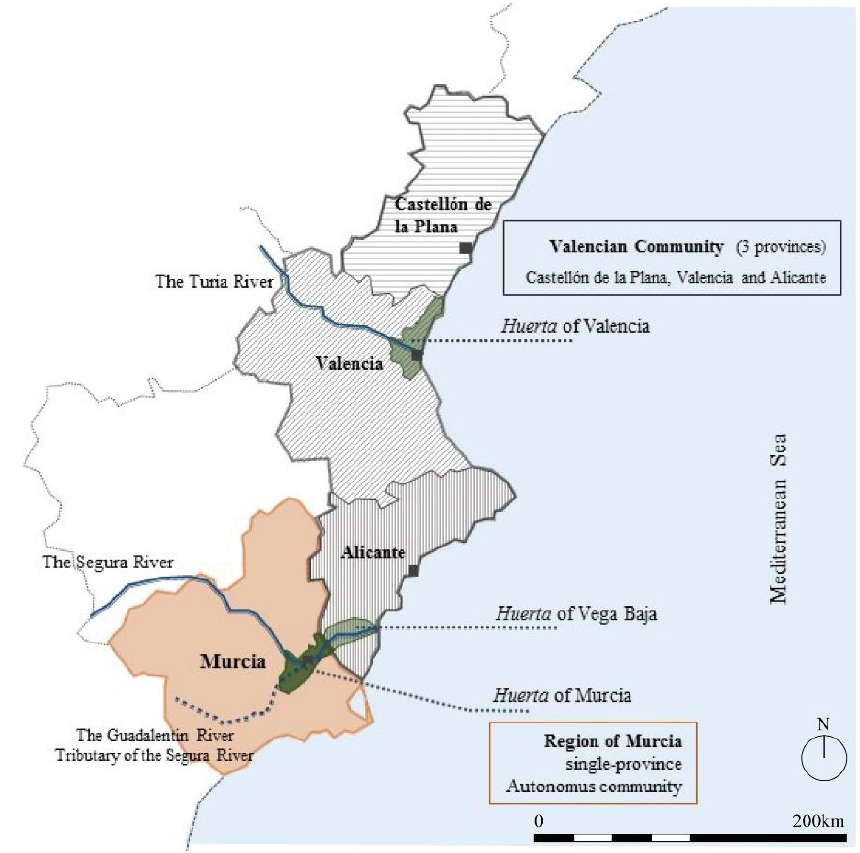
Figure 2. Location map. Regional context and main river courses related to Huerta case studies.